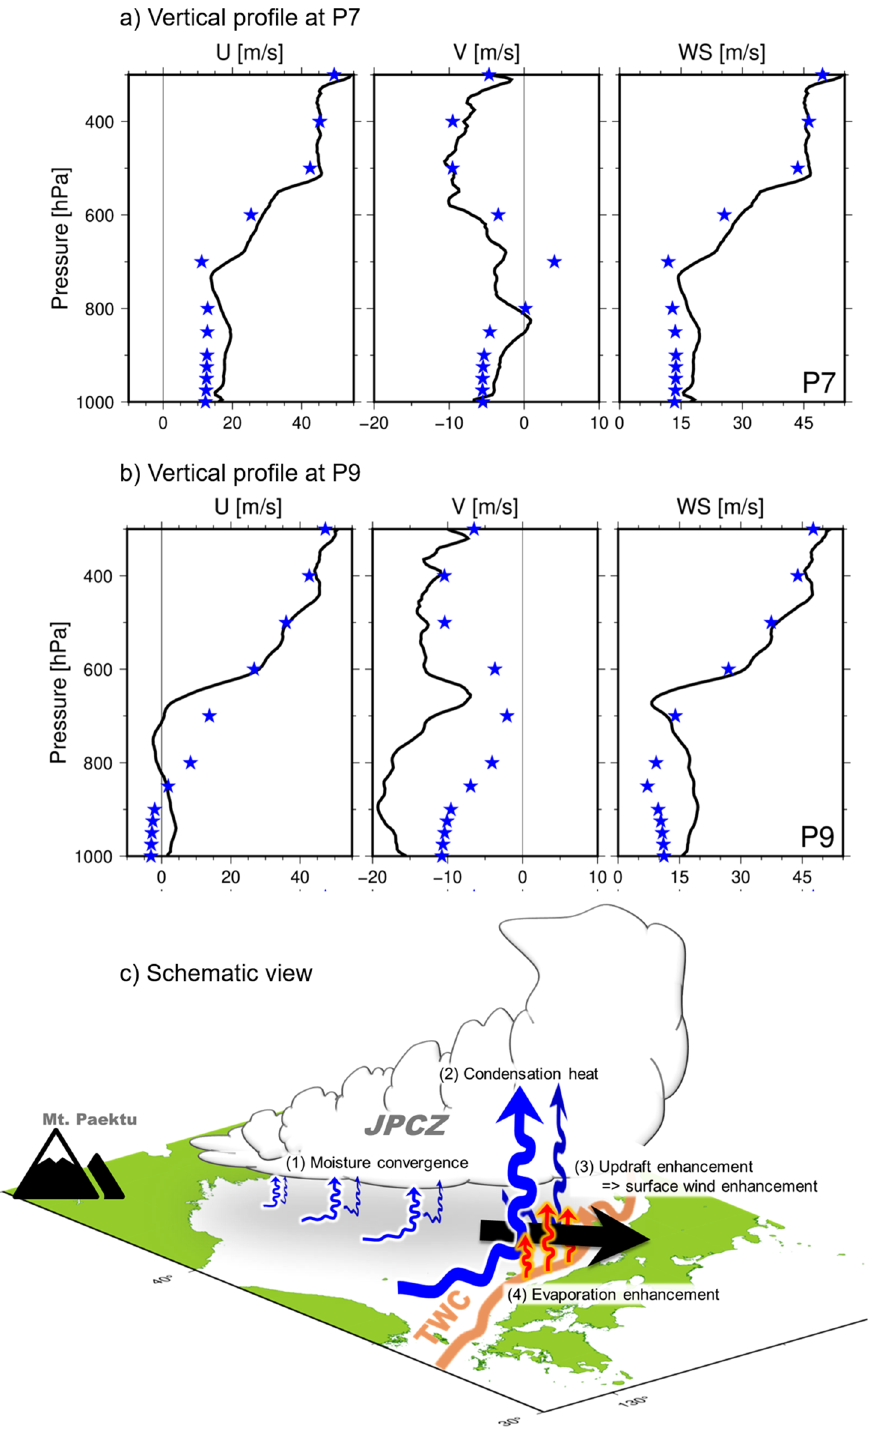
Figure 8. Plots of the observed winds in comparison to simulated winds near and off the centre of the JPCZ, and Schematics showing the self-sustaining mechanism of the JPCZ. ( a ) Observed west (U) and south (V) winds components at observation station P7 is shown by black line in the left and centre panels, respectively. Right panel shows wind speed. Stars indicate simulated wind at the same observation station and at the same time. P7 is located to the west of the centre of the JPCZ. ( b ) Same as in ( a ) but for observation station P9, which is near the centre of the JPCZ. ( c ) Schematic views. (1) Moisture from many branches converges to form a large moisture flow. This has a structure of an atmospheric river. (2) The JPCZ gains buoyancy from the condensation heat of the water vapour, and the convergence thus strengthens the updrafts. (3) The enhanced updrafts further strengthen the horizontal convergence of winds, i.e., enhanced wind speeds. (4) The enhanced wind speed further increases evaporation from the ocean and moisture convergence. Therefore, the JPCZ with the structure of atmospheric rivers has a self-sustaining